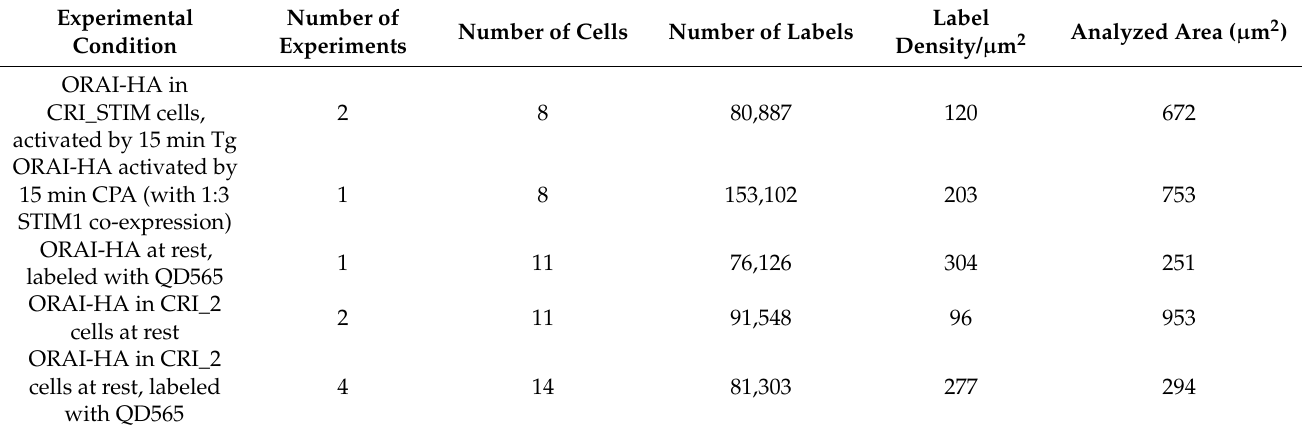
Table 3. List of control experiments performed with other cell lines, other labels, and other methods of SOCE-activation.